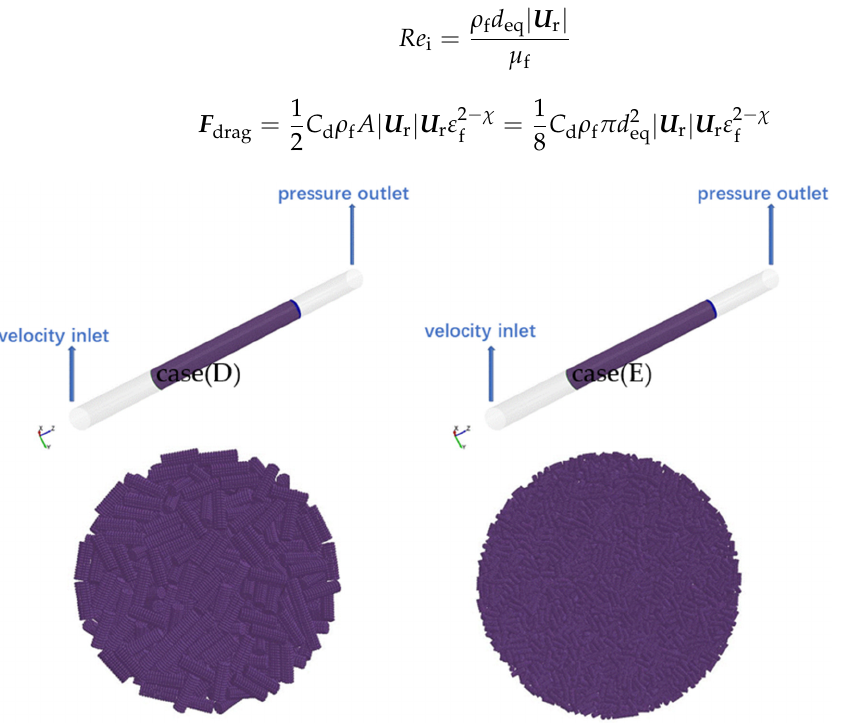
Figure 5. Two cases based on experimental study of Park et al. [34]: (D) d = 0.00498 m L = 0.0139 m; and (E) d = 0.00198 m L = 0.00495 m.